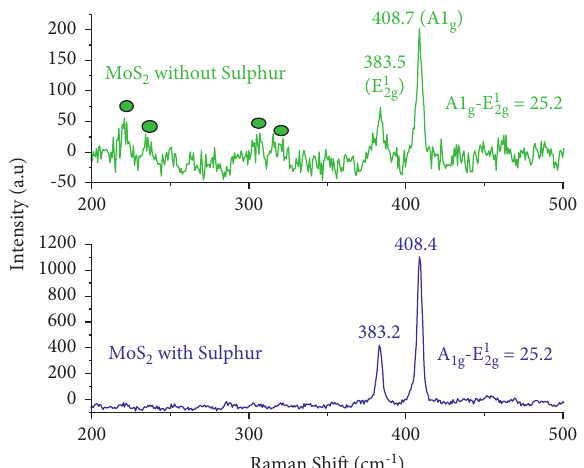
Figure 3: Raman spectrum of MoS 2 with and without sulphur confirming the growth of MoS 2 .